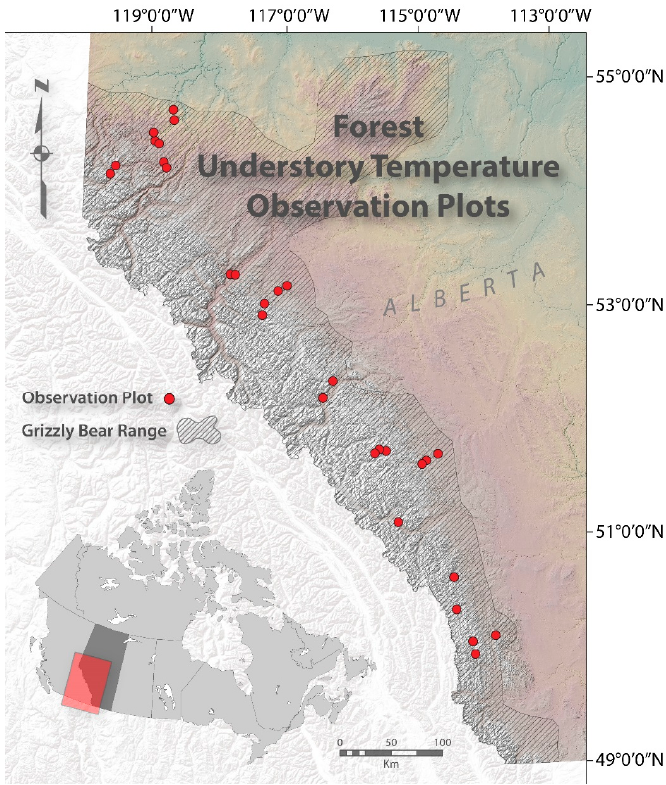
Figure 1. Study area and understory temperature observation plots.